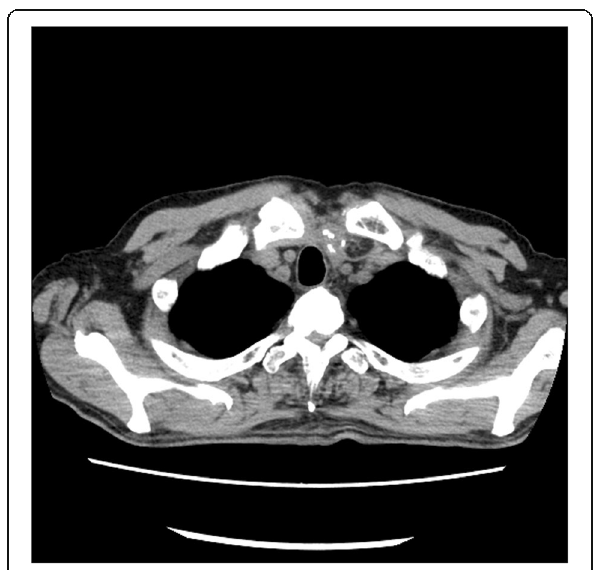
Fig. 1 Computed tomography examination. No abnormalities